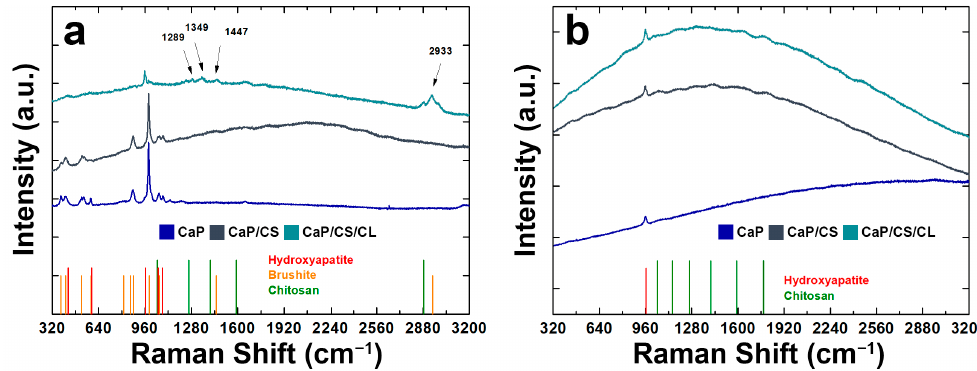
Figure 4. RAMAN spectra of CaP/CS and CaP/CS/CL coatings: ( a ) before and ( b ) after aging in SBF. The spectrum of the CaP coating was also reported for comparison.